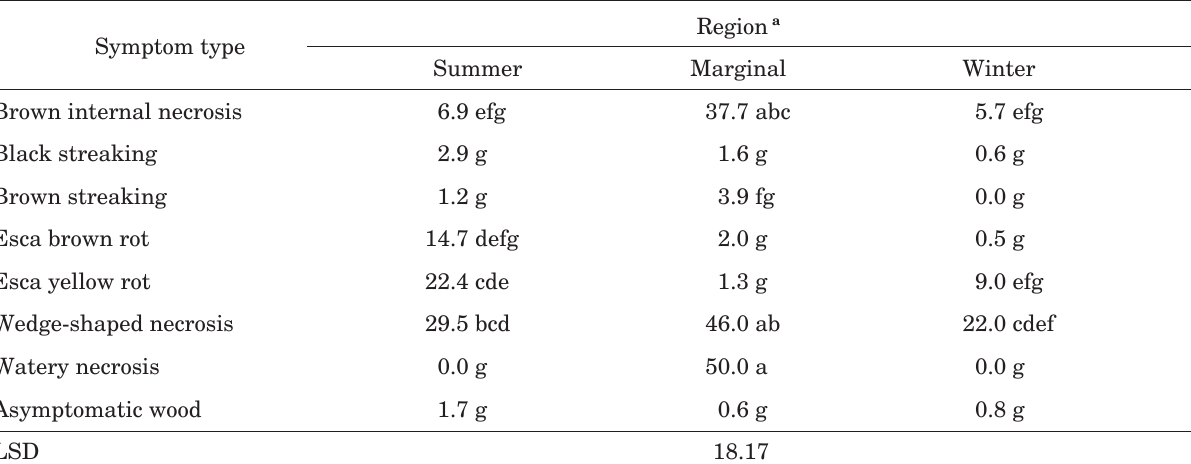
Table 6. Mean incidence of species in the Botryosphaeriaceae in isolates from vines displaying different symptoms in the summer, marginal and winter rainfall regions of South